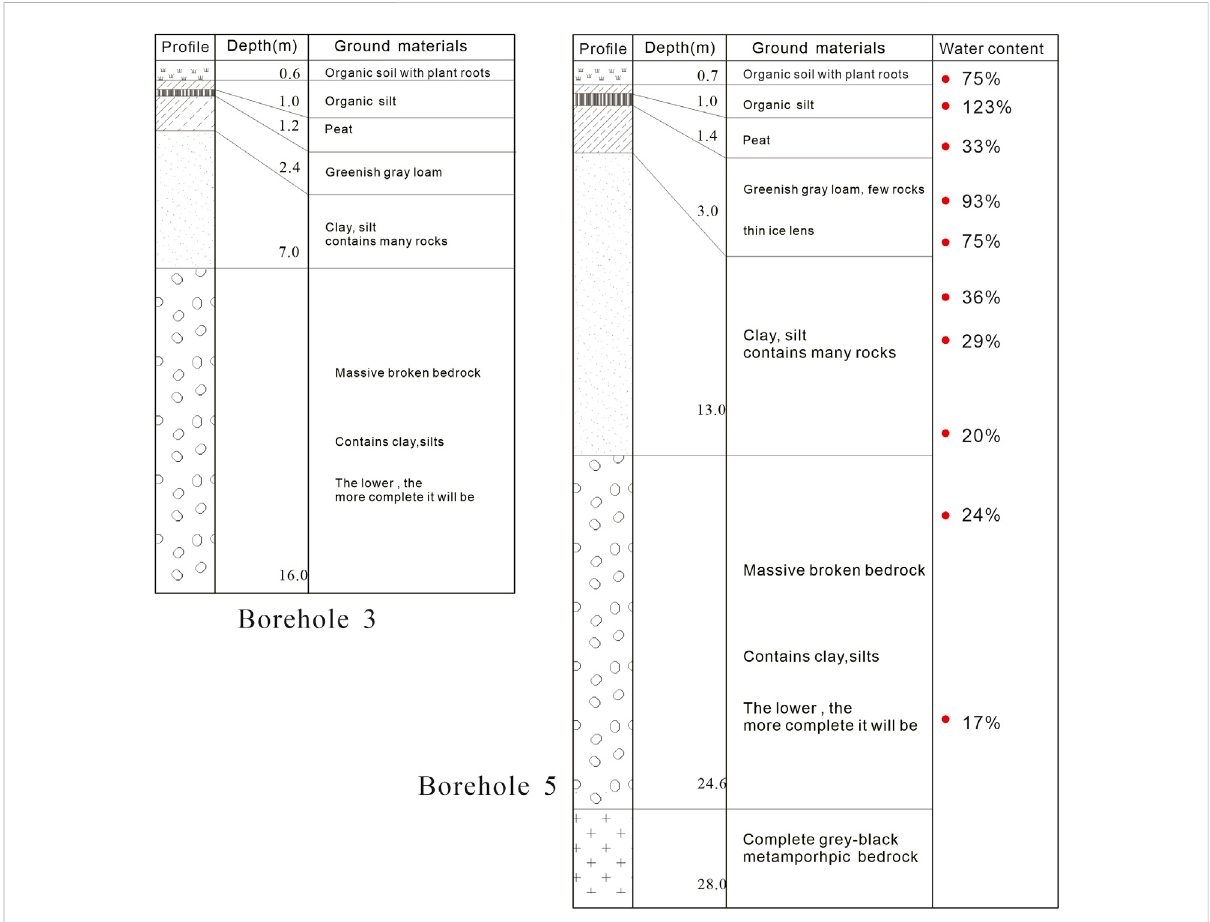
FIGURE 5 Observation map of the strata and water content in boreholes 3 and 5 in Mahan Mountain.